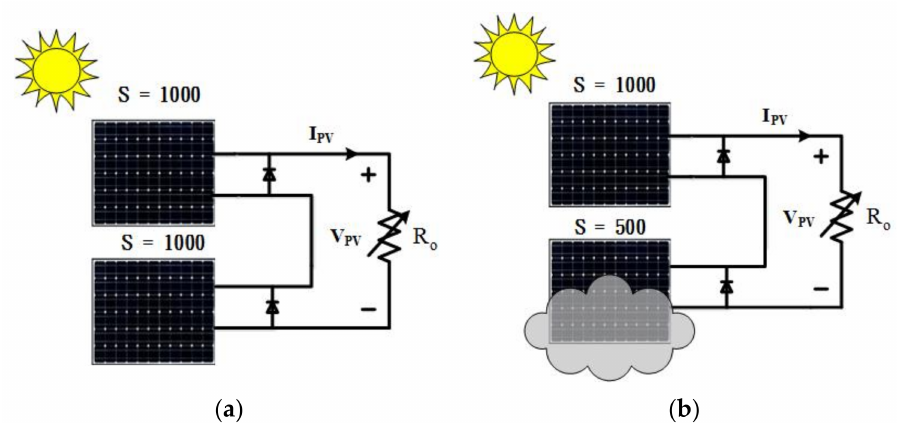
Figure 3. Schematic configuration of two PV modules connected in series, ( a ): S = 1000/1000, ( b ): S = 1000/500.